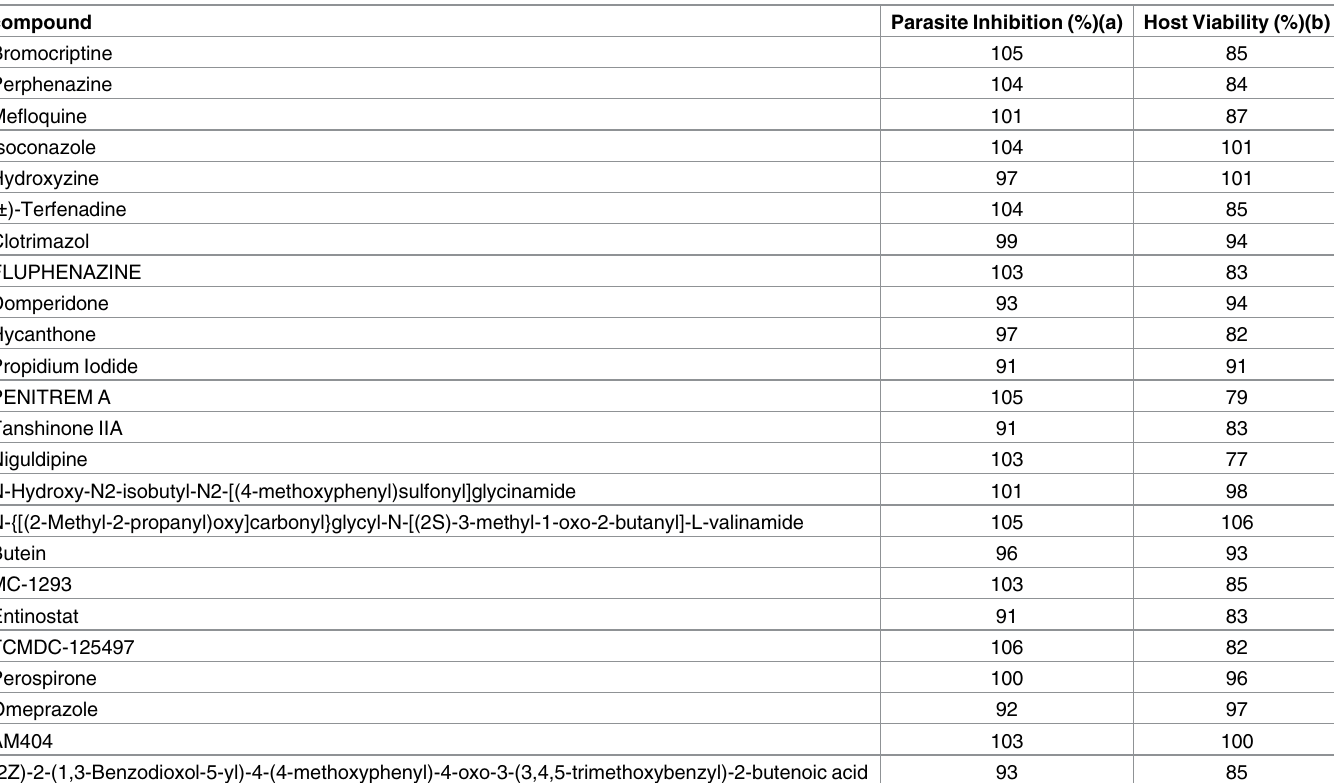
Table 1. Hit compounds from 1st